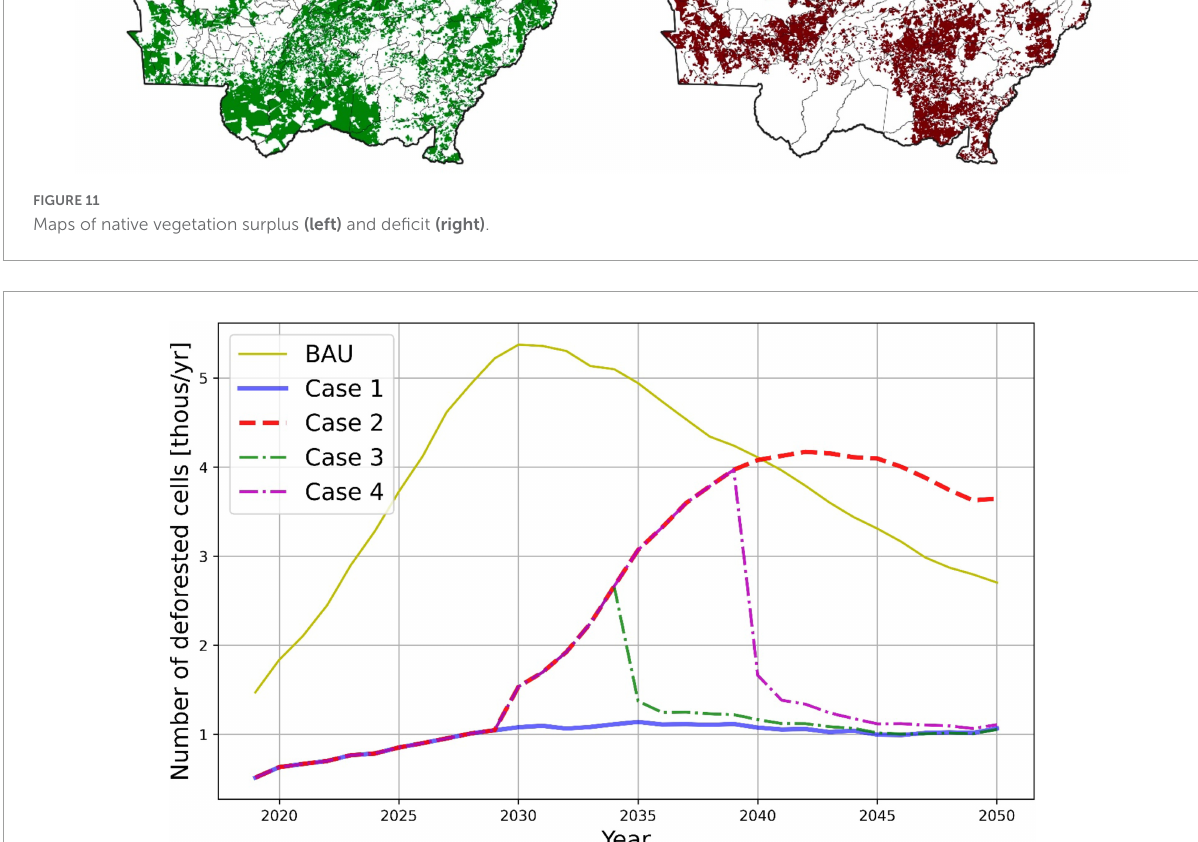
FIGURE12 Jurisdictional policy impacts compared to BAU scenario (as in Figure 9 ). Cumulative deforested areas corresponding to policy scenarios are given in Figure 13 . The figure clearly illustrates the impact of policy reversals — i.e., Cases 3 and 4 allow deforestation to be reduced to the levels close to Case 1. This has some analogy with epidemic models, where policies could be considered as quarantine measures that can be forced and relaxed by governments at various time